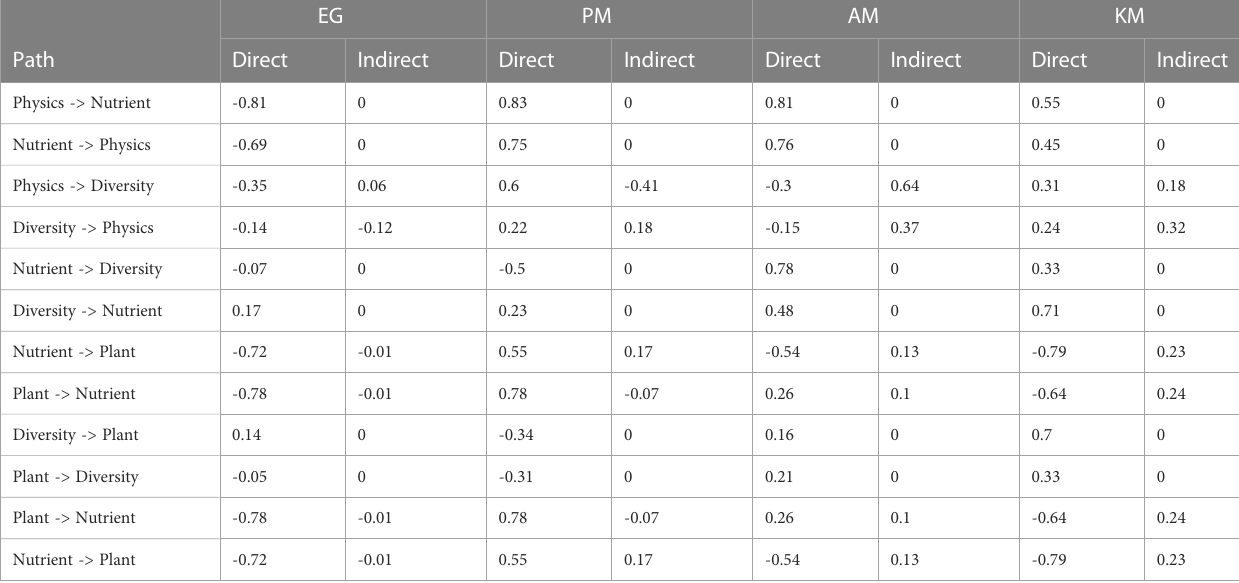
TABLE 2 Direct and indirect path effects of latent variables based on partial least squares path modeling (PLS-PM).